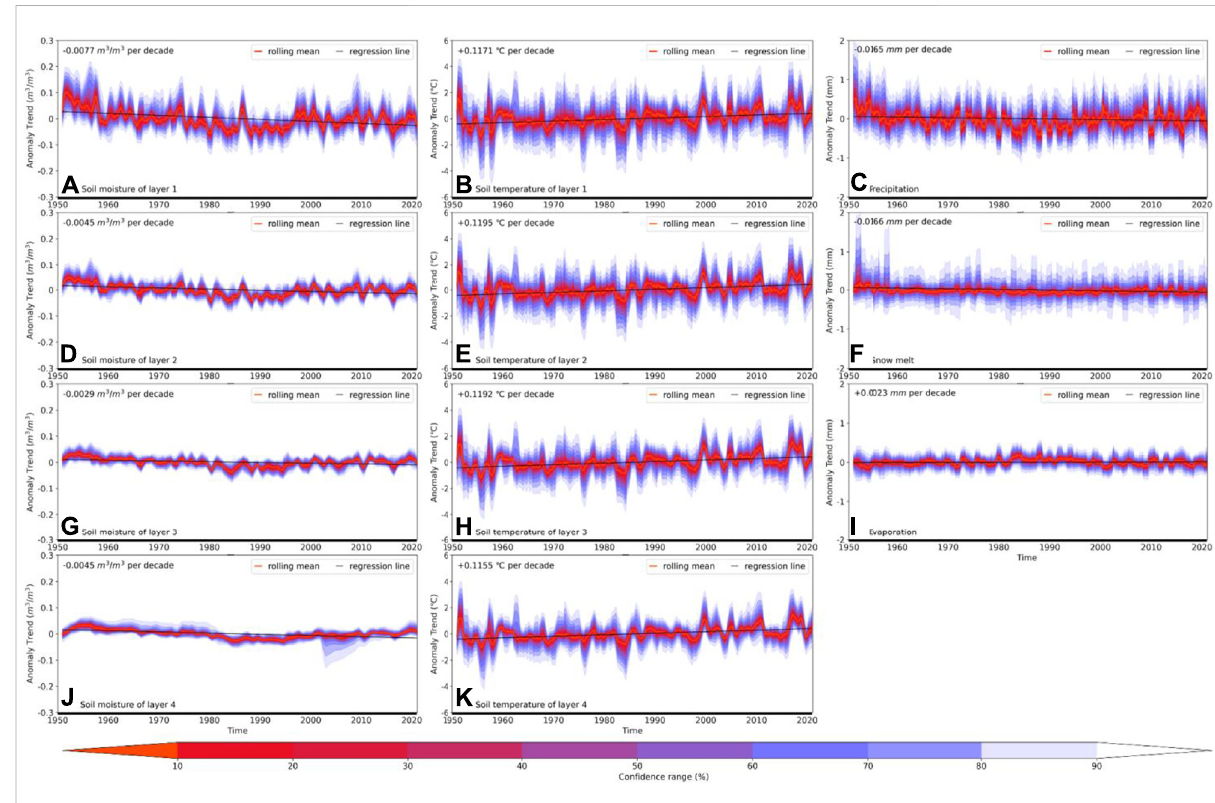
FIGURE 9 Time series of the anomaly evolutionary trends of soil moisture (A , D , G , J) , soil temperature (B , I , H , K) , precipitation (C) , snowmelt (F) , and evaporation (I) at the drying region with con fi dence ranges and regression